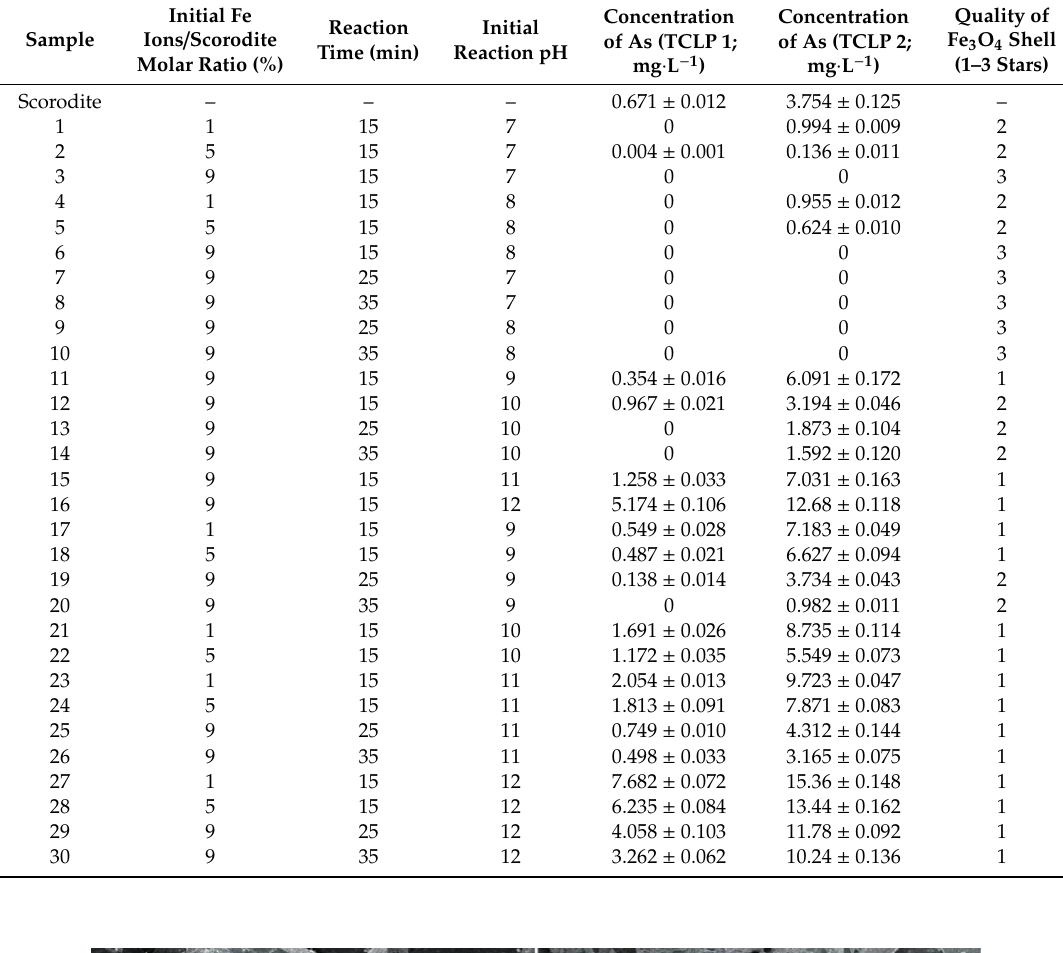
Table 2. Stability evaluation results of synthesized scorodite@Fe 3 O 4 under different conditions (toxicity characteristic leaching procedure (TCLP) 1: pH = 4.93, 18 h; TCLP 2: pH = 9.30, 24 h; 3 stars is the highest and 1 star is the lowest quality).